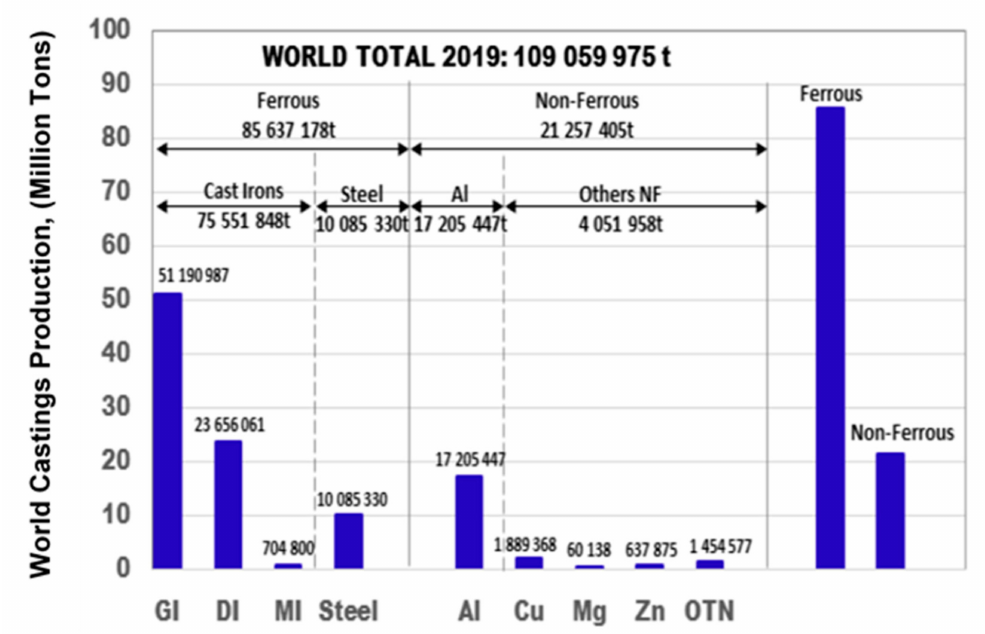
Figure 1. World metal-casting production in 2019 (GI—grey iron; DI—ductile iron; MI—malleable iron; OTN—other non-ferrous).